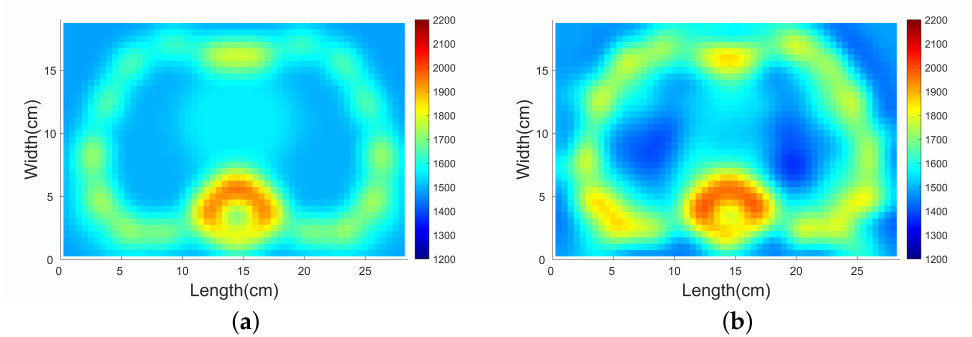
Figure 10. The new initial model and the resulf of SDM inversion. ( a ) The new initial model. ( b ) The result of SDM inversion. Colorbar: 1200–2200 m/s.